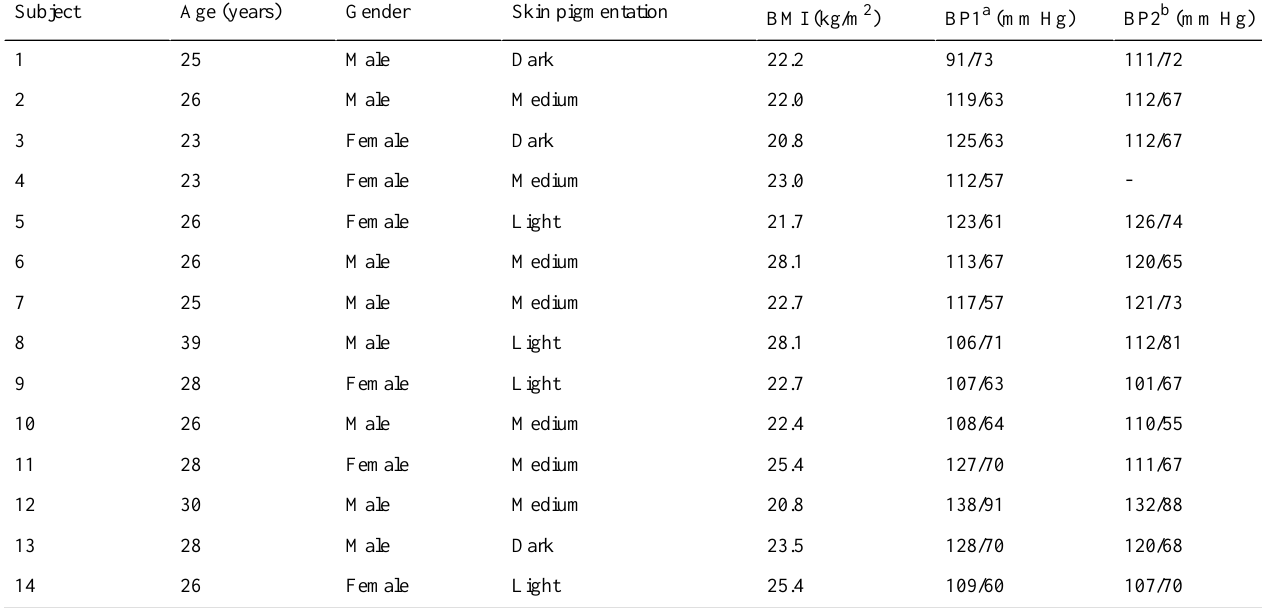
Table 2. Demographic data of the study